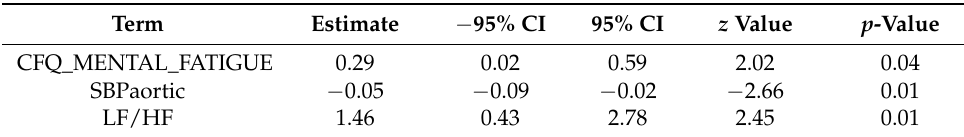
Table A1. Logistic regression predicting PEM